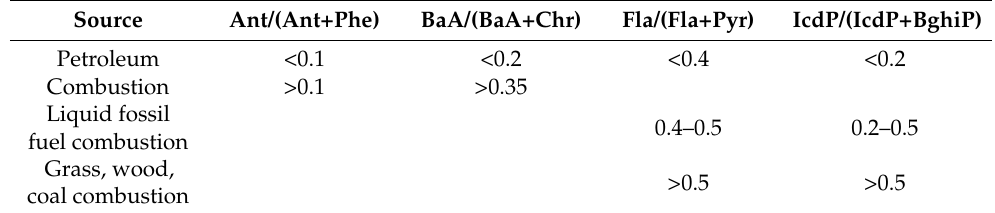
Table 2. Typical values for Ant/(Ant+Phe), BaA/(BaA+Chr), Fla/(Fla+Pyr) and IcdP/(IcdP+BghiP).